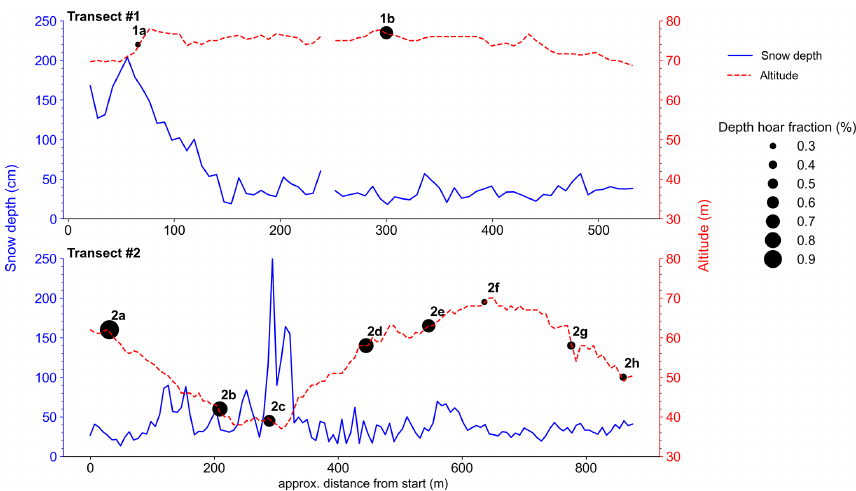
Figure 4. Snow depth (SD) transects surveyed in the Ice Creek catchment. Transect #1 and Transect #2 show snow depth (solid line) and altitude (m.a.s.l., dashed line) along transect. Mean depth hoar fractions (DHFs) are indicated along transects by proportional size. Points 1a, 1b and 2c contain one observation. See Fig. 2c for their location in the